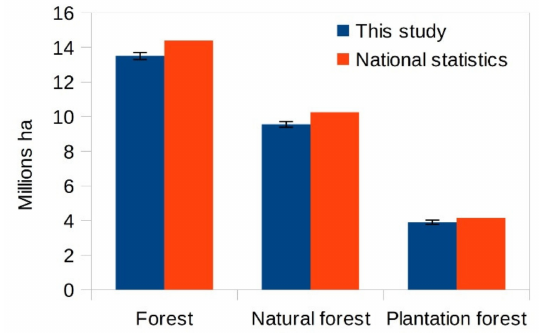
Figure 7. Comparison of forest areas between this study’s map with Vietnam national statistical